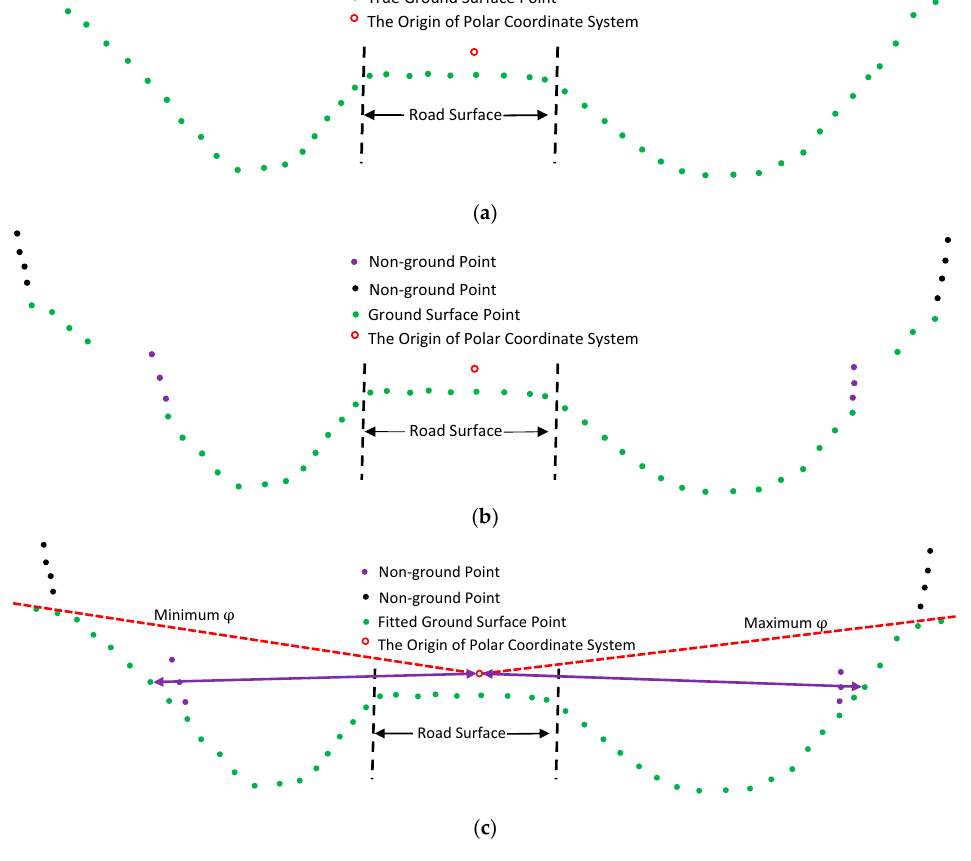
Figure 9. Multiple cross-section filtering: ( a ) True ground surface points; ( b ) The result of a single cross-section filter (SCSF); ( c ) Filtering out the non-ground surface points from the result of the SCSF by the fitted ground surface using multiple cross-sections.